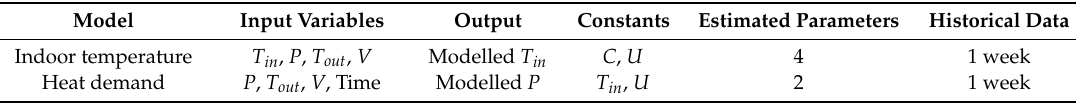
Table 4. Input variables, outputs, constants, and the number of estimated parameters for the indoor temperature and heat demand models used in the optimization of the heat demand.